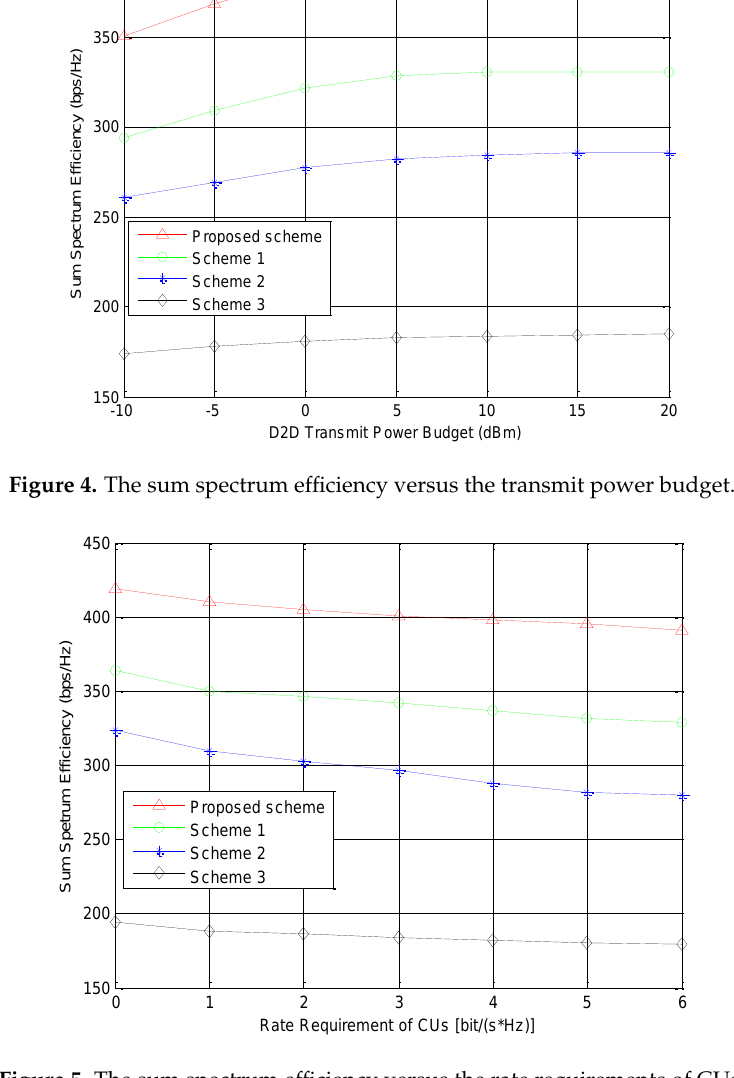
Figure 5. The sum spectrum efficiency versus the rate requirements of CUs.